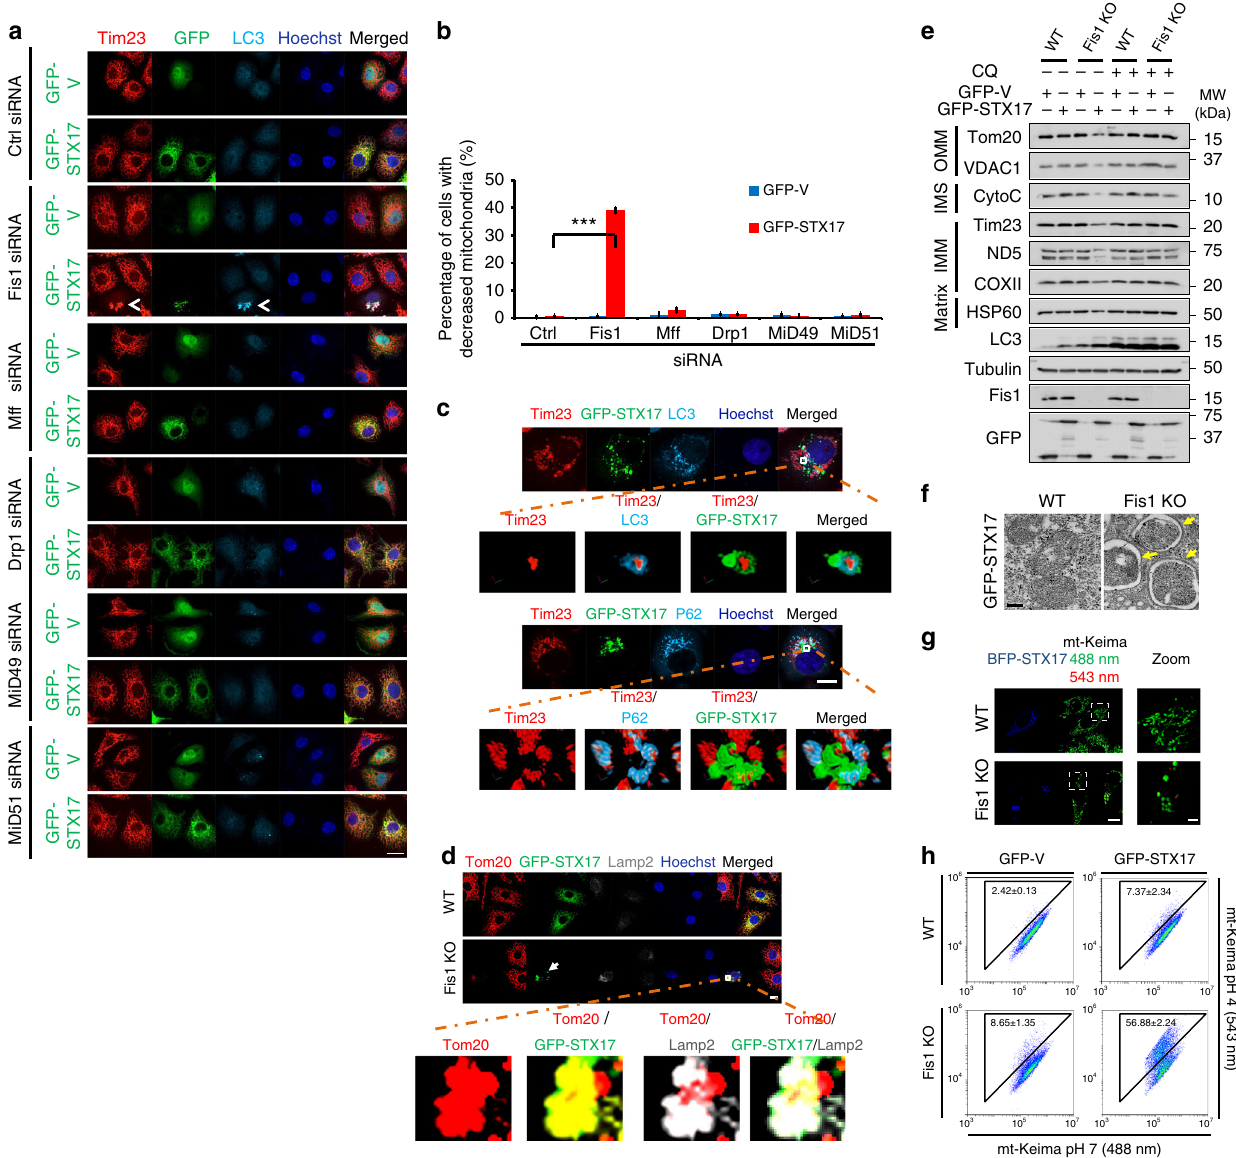
Fig. 2 Syntaxin 17 (STX17) initiates mitophagy upon mitochondrial fi ssion 1 protein (Fis1) depletion. a HeLa cells were transfected with respective small interfering RNAs (siRNAs) for 24 h, before transient transfection with green fl uorescent protein (GFP)-tagged vector or STX17 (green) for further 24 h. Cells were fi xed and immunostained with Tim23 (red) and LC3 (cyan) antibodies. Hoechst, blue. Scale bar, 10 µ m. White arrowhead indicates mitophagic cell. b Quanti fi cation of cells with decreased mitochondria as shown in a . Data are mean ± SD ( n = 150 cells from three independent experiments). *** P < 0.001 (two-tailed unpaired Student ’ s t test). c Fis1 knockout (KO) HeLa cells were transfected with GFP-tagged STX17 for 24 h. Cells were fi xed and analyzed by immuno fl uorescence against Tim23 (red) and LC3 or P62 (cyan). Z-stack images were collected and a representative three-dimensional reconstruction example is shown. Hoechst, blue. Scale bar, 10 µ m. d Wild-type ( WT ) or Fis1 KO HeLa cells were transiently transfected with GFP-tagged STX17 (green) for 24 h. Images were acquired by super-resolution structured illumination microscopy (SR-SIM) after staining for Tom20 (red) and Lamp2 (gray). Hoechst, blue. Scale bar, 10 µ m. Enlarged image represents in three-dimensional reconstruction. White arrow indicates the signal of GFP-STX17. e WT or Fis1 KO HeLa cells were transiently transfected with GFP-tagged vector or STX17 for 6 h. Cells were cultured with or without chloroquine (CQ) for further 66 h. Cell lysates were immunoblotted for outer mitochondrial membrane (OMM), intermembrane space (IMS), inner membrane mitochondrial (IMM), and matrix proteins. f WT or Fis1 KO HeLa cells transiently expressing GFP-tagged STX17 were analyzed by conventional transmission electron microscopy. Scale bars, 0.2 µ m. Yellow arrows indicate autophagic structures enclosing mitochondria. g WT or Fis1 KO HeLa cells stably expressing mitochondrial-targeted form of the fl uorescent reporter Keima (mt-Keima) were transiently transfected with blue fl uorescent protein (BFP)-tagged STX17 (blue). Live cells were visualized by confocal microscopy excited with 488 nm (green) and 543 nm (red). Scale bar, 10 μ m. h WT or Fis1 KO HeLa cells stably expressing mt-Keima were transiently transfected with GFP-tagged vector or STX17 for 48 h. mt-Keima fl uorescence in GFP-positive cells was measured using fl ow cytometry by excitation at 488 nm (neutral) and 543 nm (acidic). Data are mean ± SD ( n = 3)